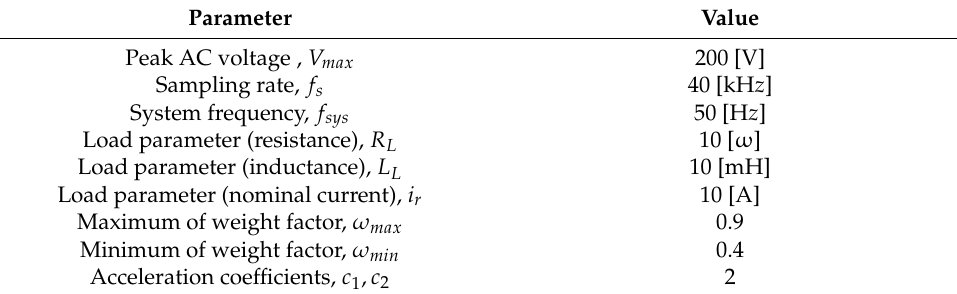
Table 1. System Parameters in